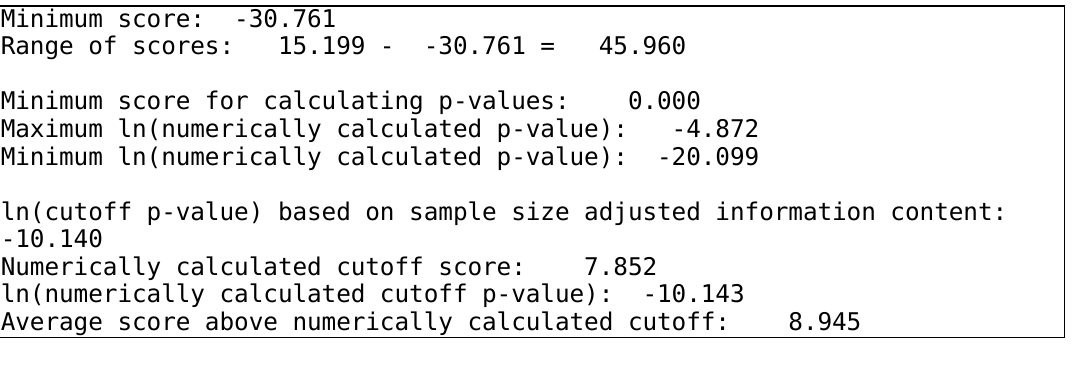
Supplementary Table 4 (S4): List of studied D. radiodurans genes related to replication, repair and recombination functions with their phylogenetic pattern and respective